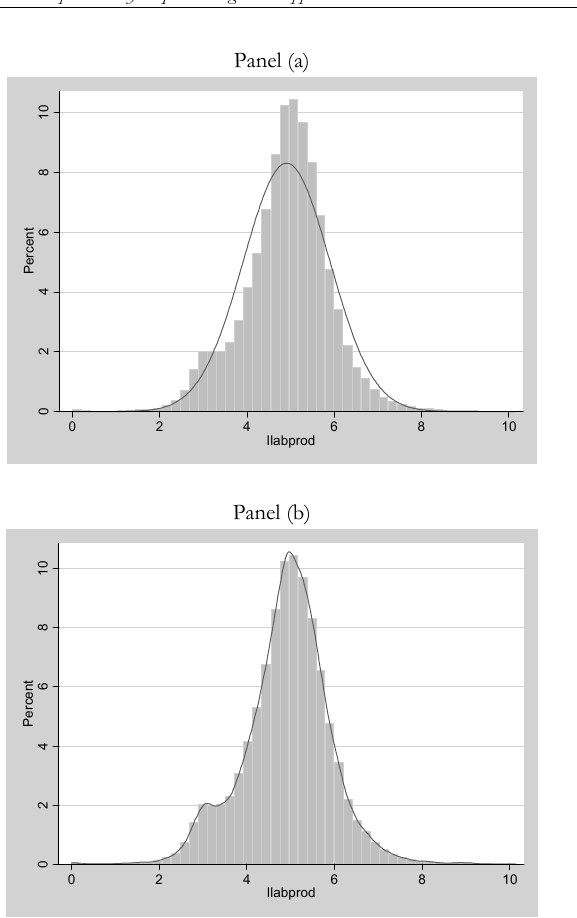
Figure 1 – Histogram and Normal Density Plot (Panel a) and Kernel Density Plot (Panel b) of Labor Productivity (in logs).